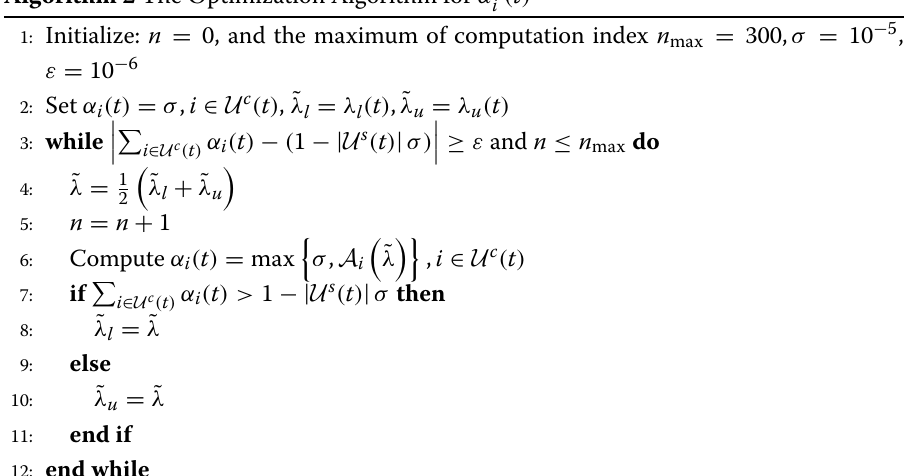
Algorithm 2 The Optimization Algorithm for α ∗